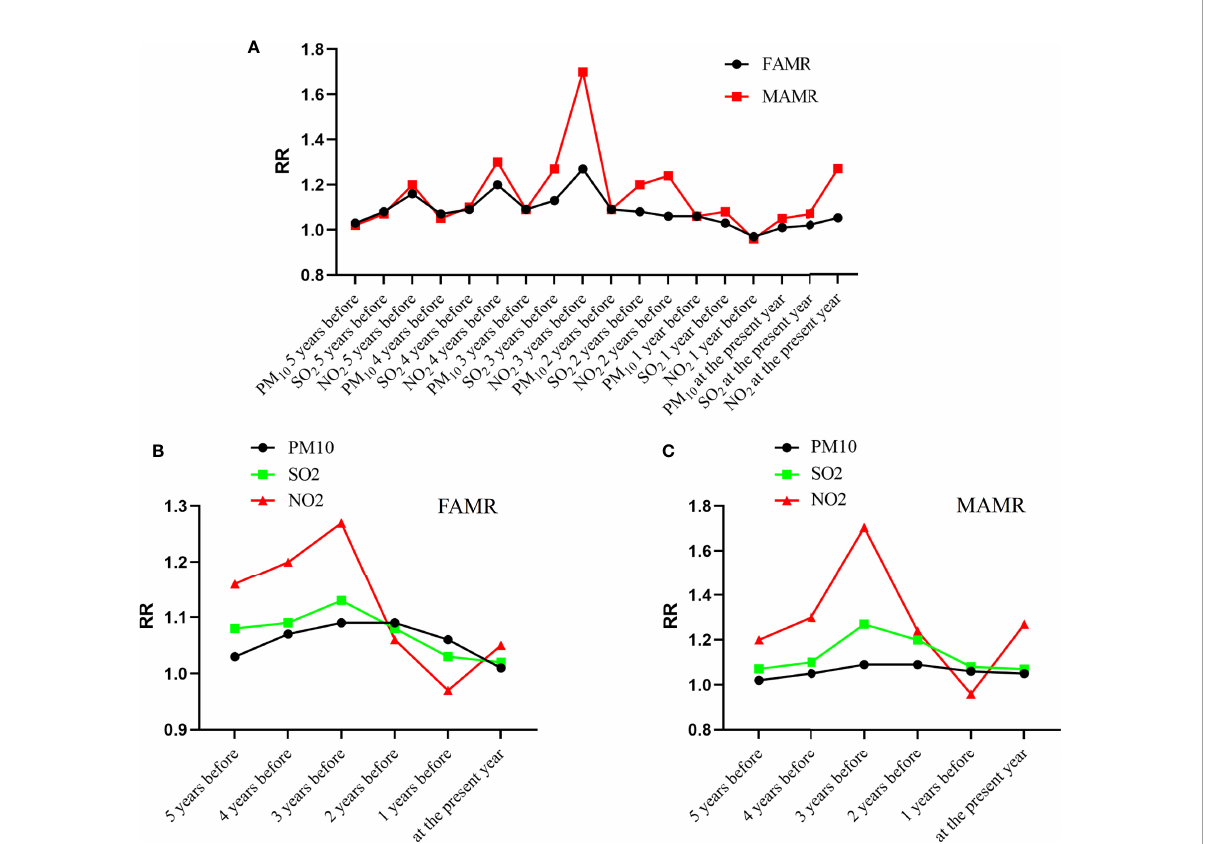
FIGURE 7 Air pollutant-related lung cancer mortality within a 5-year moving exposure window. (A) RR values of FAMR and MAMR related to the air pollutants; (B) RR values of FAMR related to individual air pollutants PM 10 , SO 2 and NO 2 ; (C) RR values of MAMR related to individual air pollutants PM 10 , SO 2 and NO 2 . RR, risk ratio; FAMR, female age-adjusted mortality rate; MAMR, male age-adjusted mortality